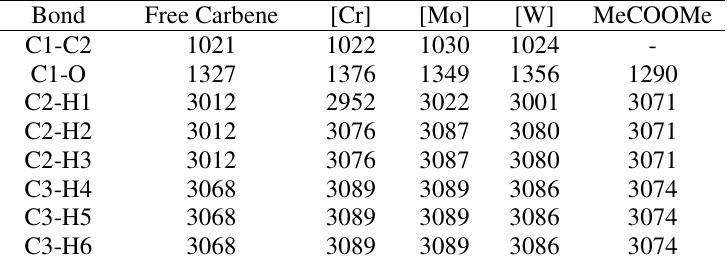
Table 4 . Selected infrared frequencies, cm -1